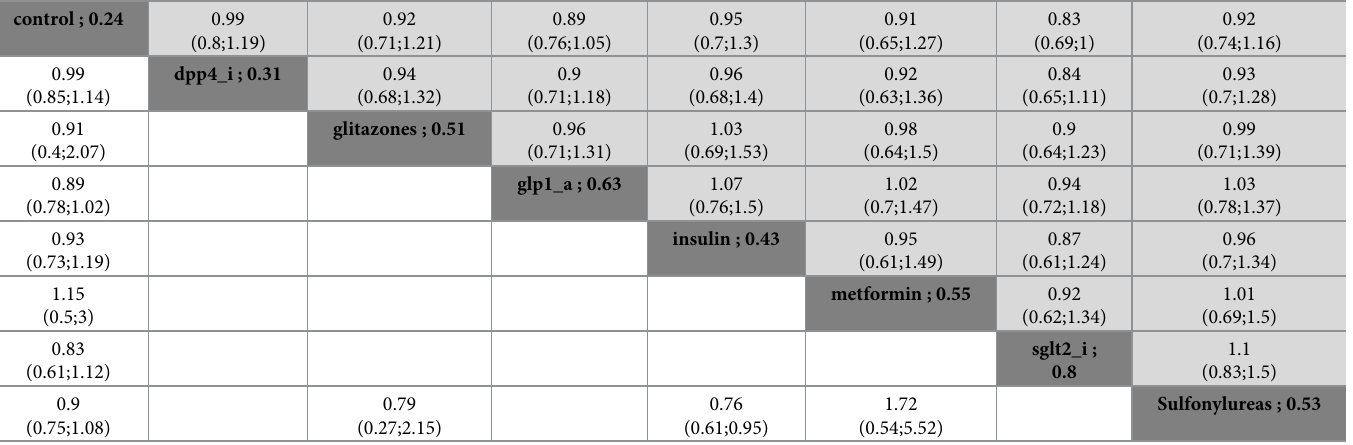
TROL, S3C Fig_GLP-1_A VERSUS CONTROL, S3C Fig_INSULIN VERSUS CONTROL, S3C Fig_METFORMIN VERSUS CONTROL, S3C Fig_SGLT-2_I VERSUS CONTROL, S3C Fig_SULFONYLUREA VERSUS CONTROL, S3C Fig_SULFONYLUREA VERSUS GLI- TAZONES, S3C Fig_INSULIN VERSUS SULFONYLUREA, S3C Fig_METFORMIN VERSUS SULFONYLUREA. Compared to control, only SGLT-2 inhibitors and GLP-1 receptor agonists were associated with a decreased risk of MACE (OR = 0.89 [95% CrI: 0.81; 0.98] and OR = 0.88 [95% CrI: 0.81; 0.95], respectively). Compared to DPP-4 inhibitors, only GLP-1 receptor ago-